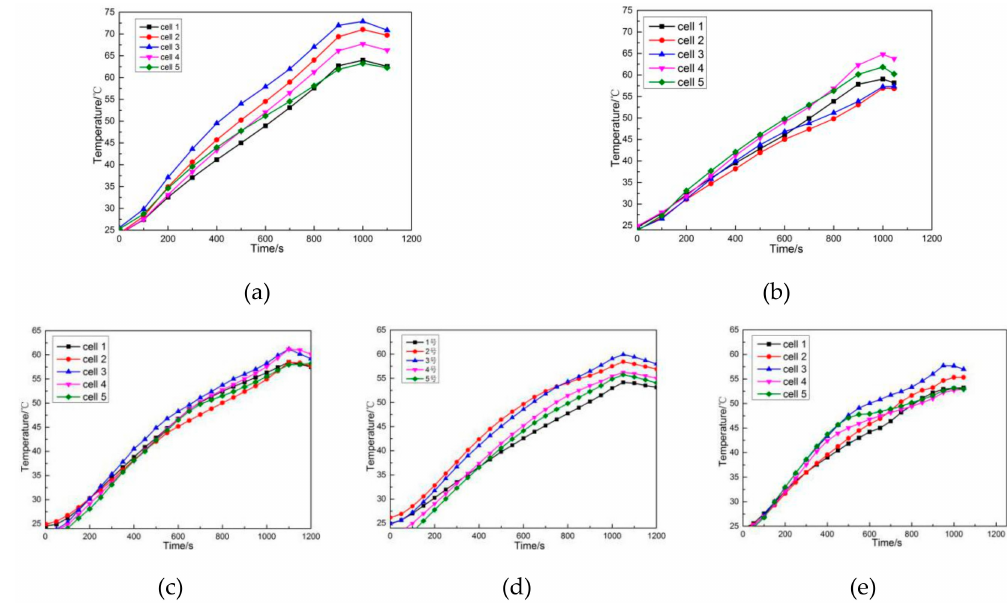
Figure 10. Surface temperature curve of the battery under di ff erent EG content of 3C discharge rate: ( a ) 0% EG; ( b ) 5% EG; ( c ) 10% EG; ( d ) 15% EG; ( e ) 20%